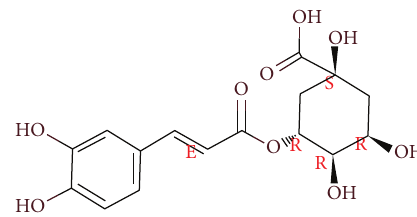
Figure 1: Structure of CGA